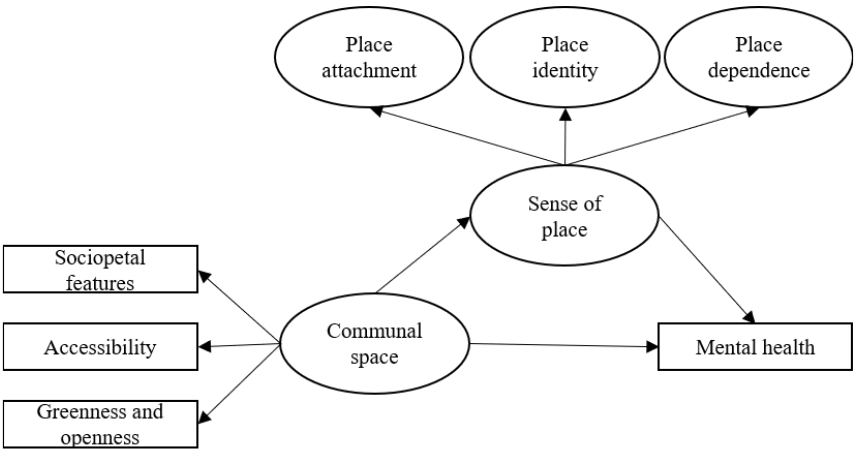
Figure 1. Conceptual framework of communal space, sense of place and mental health.